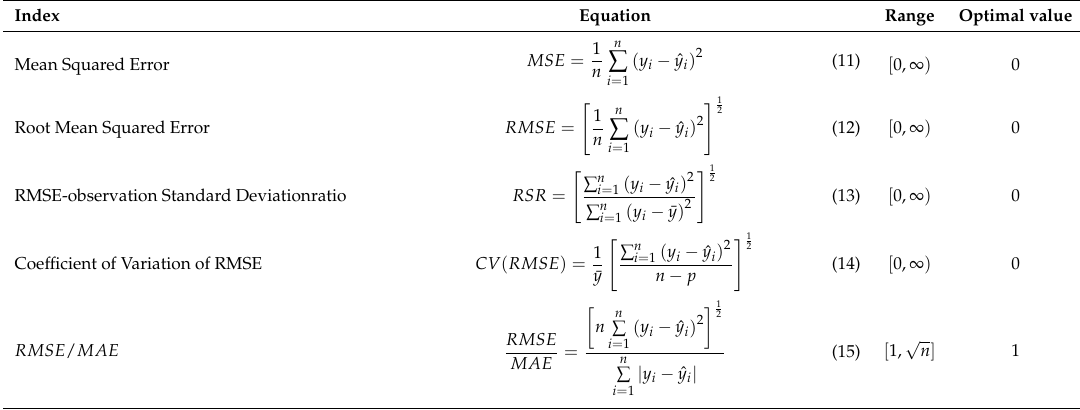
Table 3. Square deviations measures.